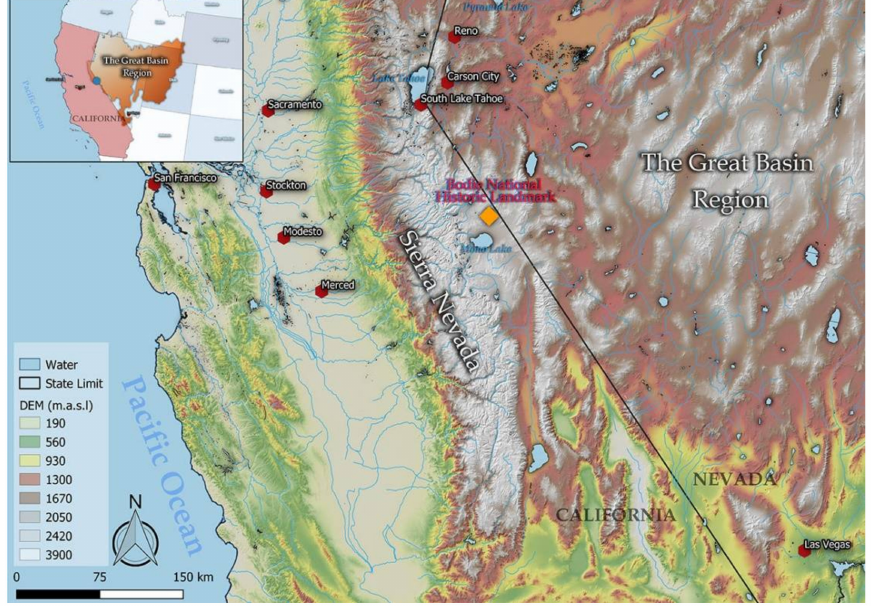
Figure 2. Map showing Bodie’s location in the Western United States, nearby cities in California and Nevada, the Sierra Nevada mountain range, and the hydrographic Great Basin Region. Map by M. Dueñas